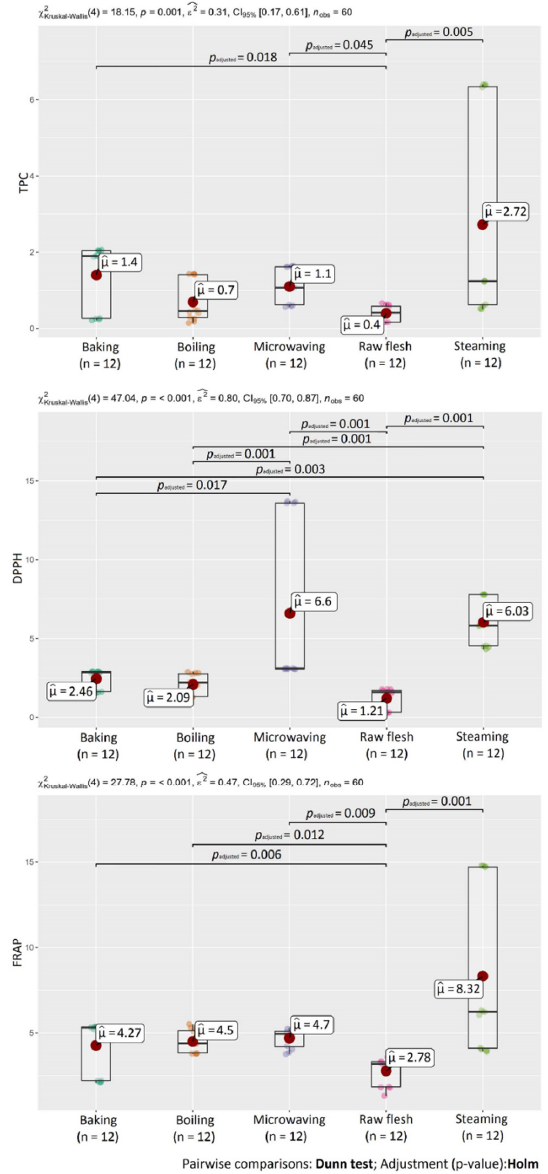
Figure 7. Statistical differences in TPC, DPPH, and FRAP between heat treatment methods.